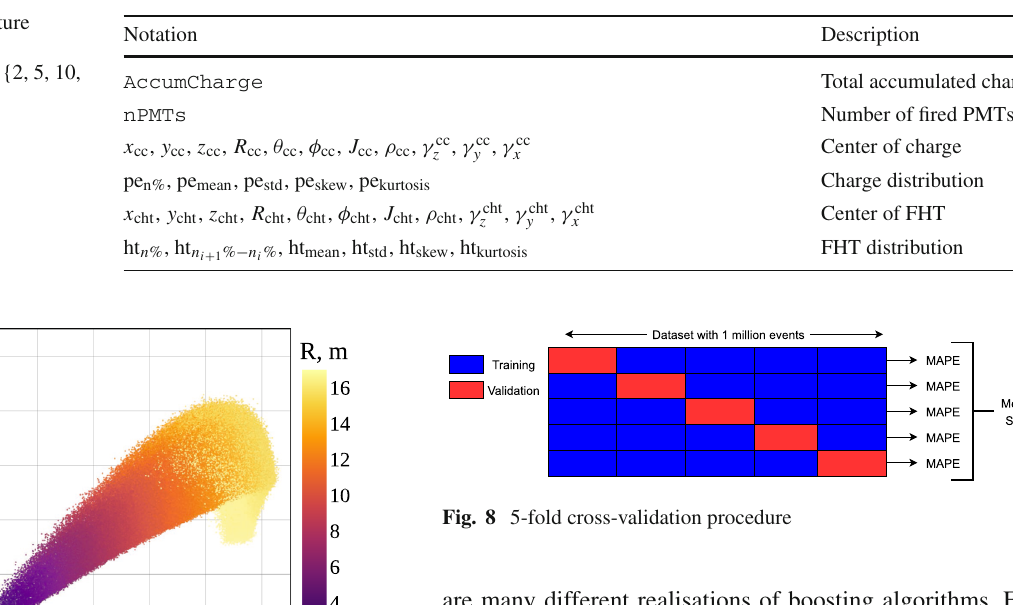
output pairs. Boosted Decision Trees (BDT) is one of such algorithms [27,28].